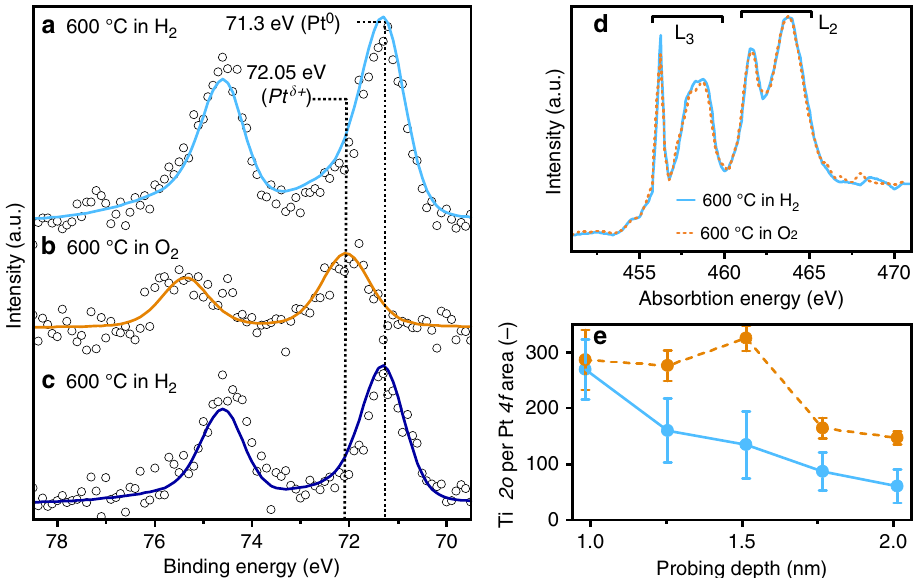
Fig. 3 In situ spectroscopy. APXPS (650 eV photon energy) at 600 °C of the Pt 4f peak with respective peak fi ttings (Donjac – Sunjic for a , c and Gaussian – Lorentian for b ): after the fi rst H 2 (0.15 mbar) exposure at 600°C ( a ), the Pt signal intensity decreased by 50% after exposure to 1 mbar O 2 ( b ); a subsequent switch to H 2 ( c ) increased the signal intensity but total intensity remained low. NEXAFS spectra of the Ti L 2,3 edge ( d ) acquired during the in situ XPS set-up. The second peak (e g ) exhibits speci fi c peak shapes for different TiO 2 polymorphs and oxidation state. Under O 2 at 600 °C characteristics of titania rutile are visible. Under H 2 the lack of this feature is characteristic of Ti 2 O 3 or amorphous titania. Depth pro fi ling ( e ) under H 2 at 600 °C (blue) and after the switch to O 2 (orange). The probing depth was calculated based on the inelastic mean free path of photoelectrons in titania. The results indicate that a titania layer covered the platinum nanoparticles and that this layer is thicker while dosing oxygen. Error bars in e were calculated by Gaussian error propagation of the standard deviation of the Pt 4f and Ti 2p peak fi